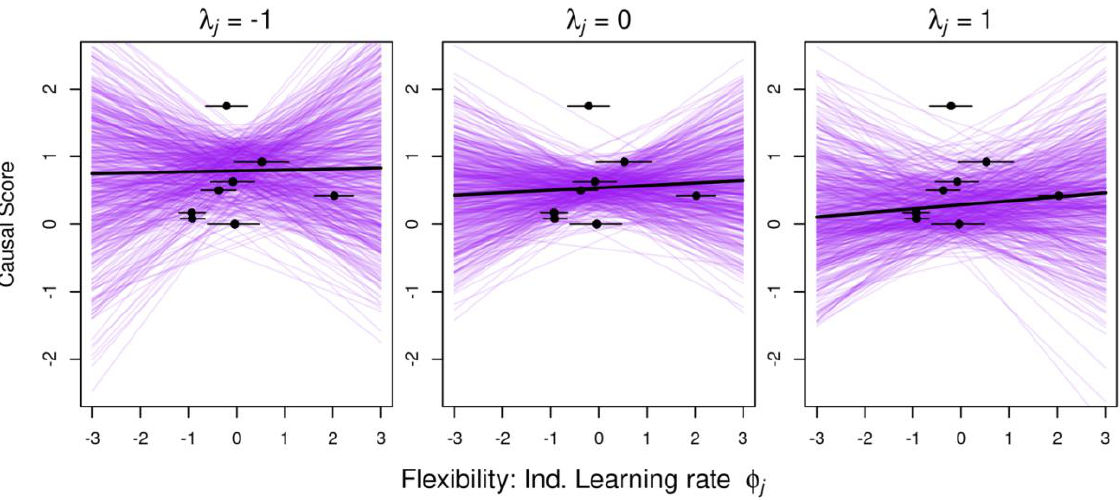
Figure 5 . Results from the computational learning model (flexibility 4). Posterior predicted causal score based on estimates for the individual-level learning rates from the reinforcement learning model ( 𝜙𝑗 ; black dots show posterior means and horizontal lines indicate 89% highest posterior density intervals). Curves are plotted for high (left; 𝜆𝑗 =-1), average (middle; 𝜆𝑗 =0) and low (right; 𝜆𝑗 =1) random choice rates. Purple lines represent 200 independent draws from the posterior. Both predictors ( 𝜆𝑗 and 𝜙𝑗 ) were standardized before